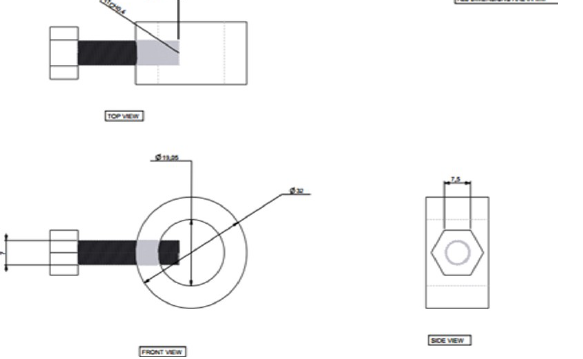
FIG.14 2D VIEWS OF ROUND NYLON PLATE